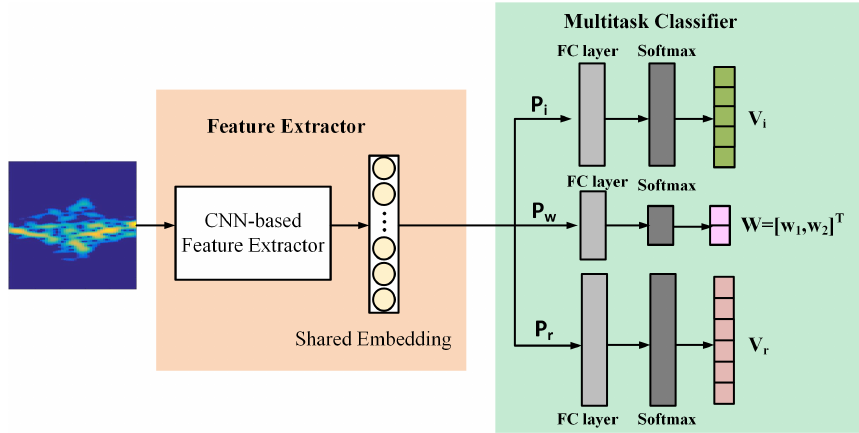
Figure 1. The CNN-based framework of the proposed MRA-Net . The model is composed of two parts: feature extractor and multitask classifier. In the multitask classifier part, there are three branches: activity recognition branch P r , person identification branch P i and FLWL branch P w . There is a FC layer and a Softmax layer in P i and P w , respectively, and V i and V r denote the corresponding output vectors that are utilized for the final classifications of the two tasks. W denotes the output vector that is utilized for the automatic loss weight